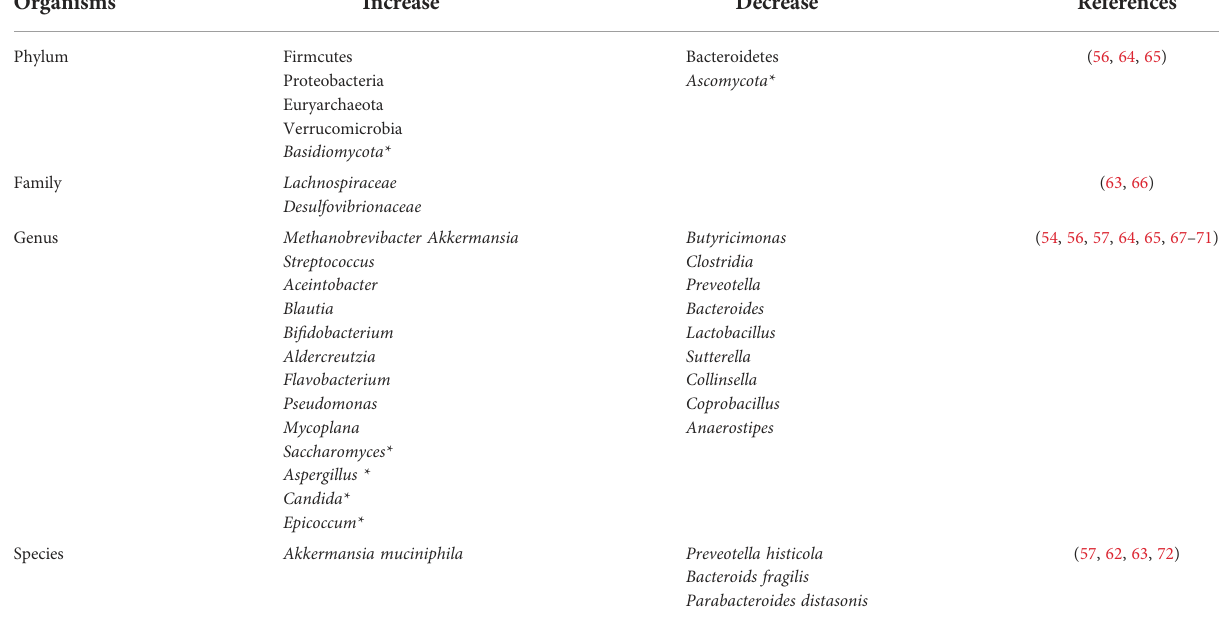
TABLE 1 Reported changes in gut microbiome of MS patients cohorts. Organisms Increase